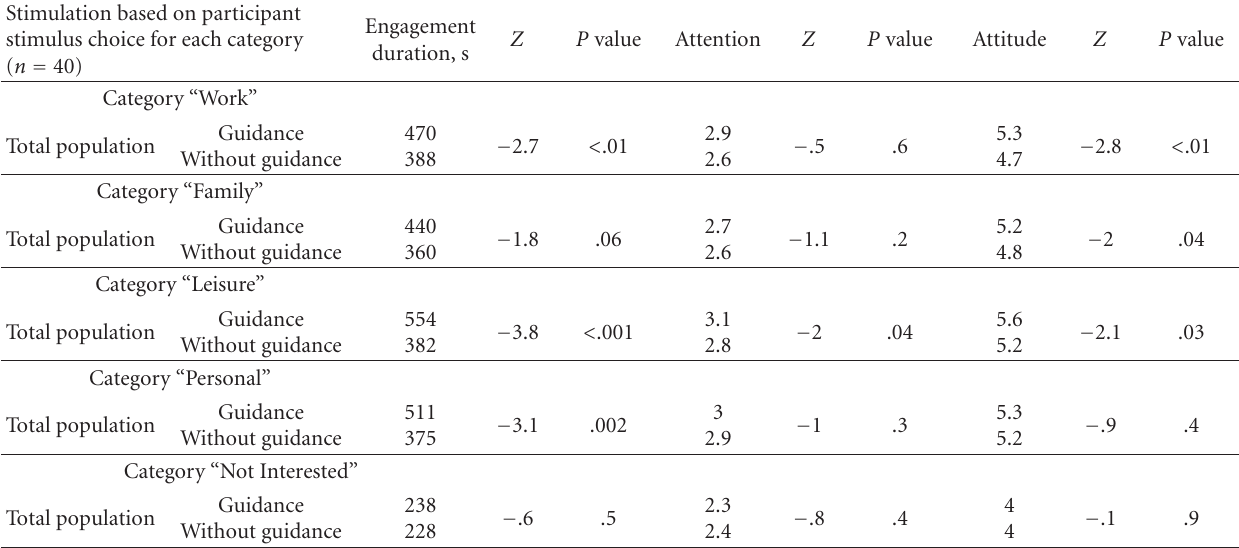
Table 3: Observational measurement of engagement (OME) scores in guided and unguided conditions for the total population. Stimulation based on participant stimulus choice for each